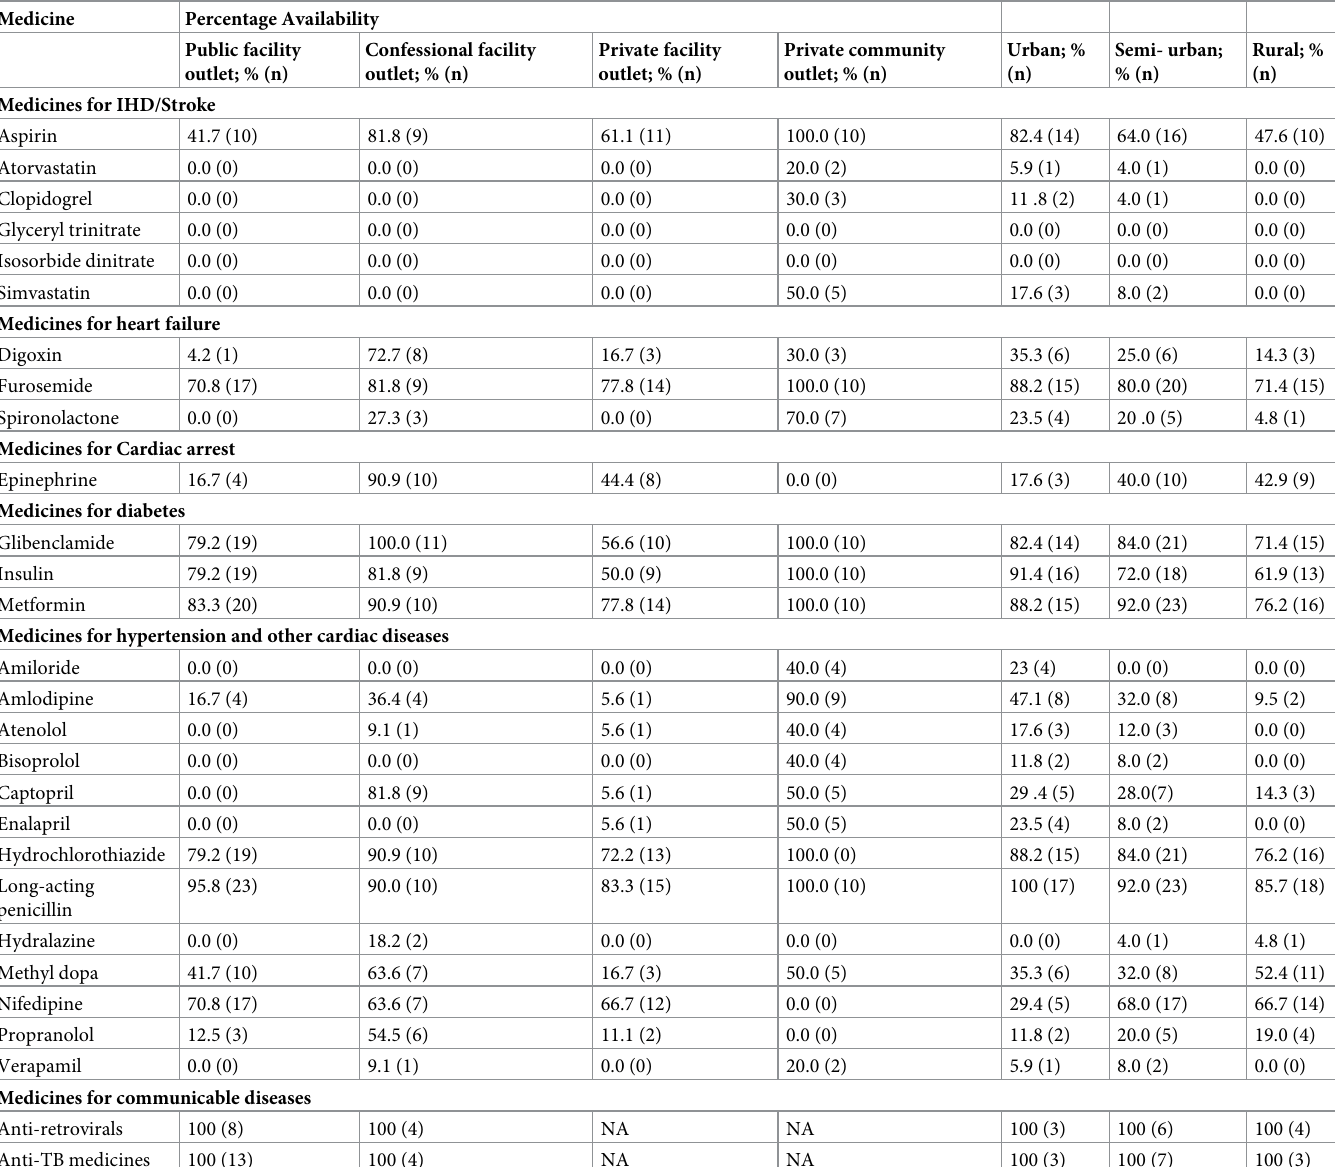
Table 2. Availability of all medicines across surveyed medicine outlets and by urbanicity.